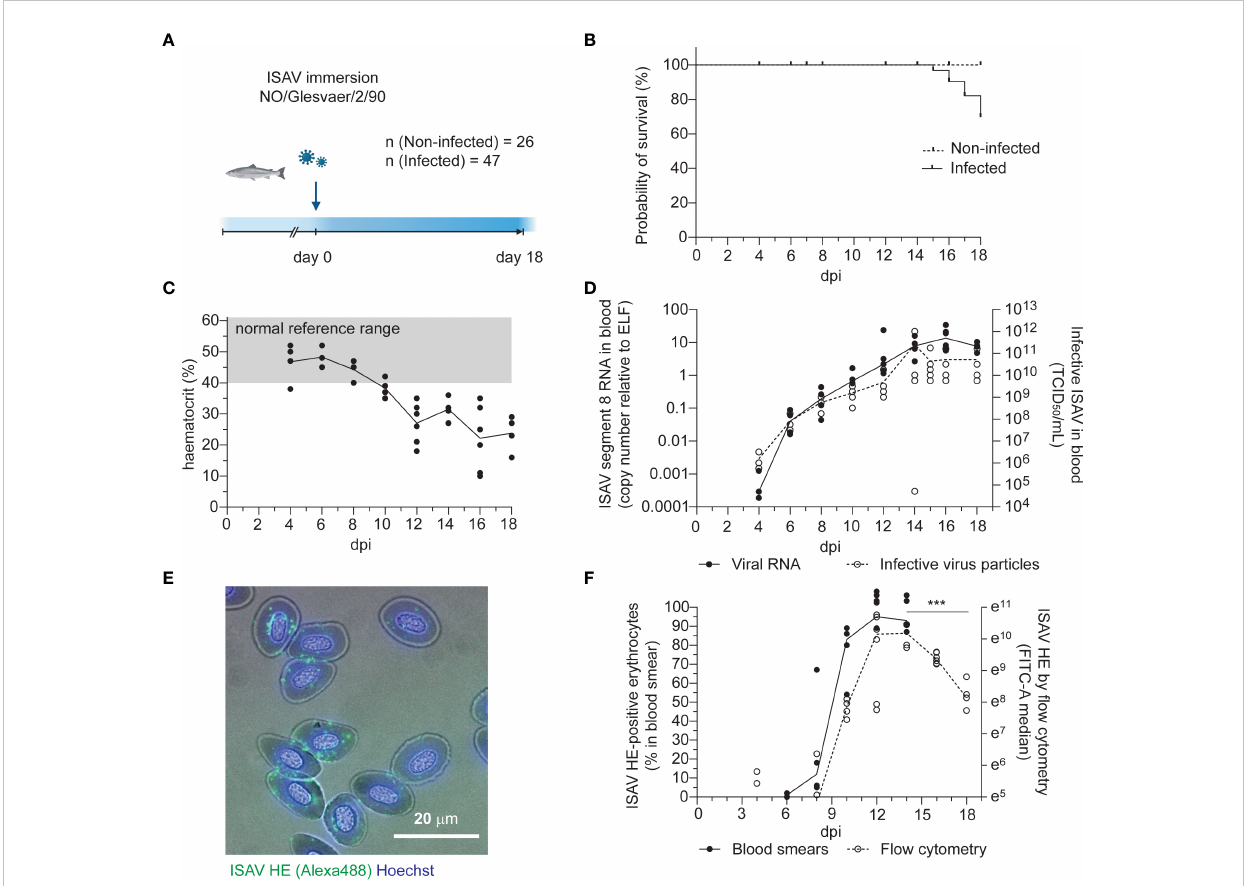
FIGURE 1 Disease and viraemia in experimentally infected fi sh. (A) Outline of the infection trial. Atlantic salmon were challenged with ISAV (NO/Glesvaer/2/90, 2 hours immersion) and followed for 18 days. The illustration was created in BioRender.com. (B) Cumulative mortality in the infected fi sh group. No deaths occurred in the non-infected group. (C) Hematocrits (HCT) of infected fi sh. Data points represent individual fi sh, and the line connects median values. The reference range (grey shading) is based on blood samples from 25 non-infected fi sh (mean +/- 2 standard deviation). (D) Viral RNA and infective particles in blood were measured by qPCR targeting ISAV segment 8 (left y-axis, black dots and line) and titration on ASK cells (right y-axis, open circles, stippled line). Data points represent individual fi sh, lines connect median values. (E) Representative micrograph of an acetone- fi xed blood smear from an infected fi sh (12 dpi) immunostained for HE (clone 3H6F8, green/Alexa488). Nuclei are counterstained with Hoechst 33342 (blue), and bright fi eld contrast shows the outline of the cells. The scale bar measures 20 m m. (F) The percentage of HE-positive cells in acetone- fi xed blood smears were counted manually (black dots and line). PFA- fi xed blood cells from infected fi sh were immunostained for HE, and the signal was measured by fl ow cytometry (open circles, stippled line). Data points represent individual fi sh. Lines connects median